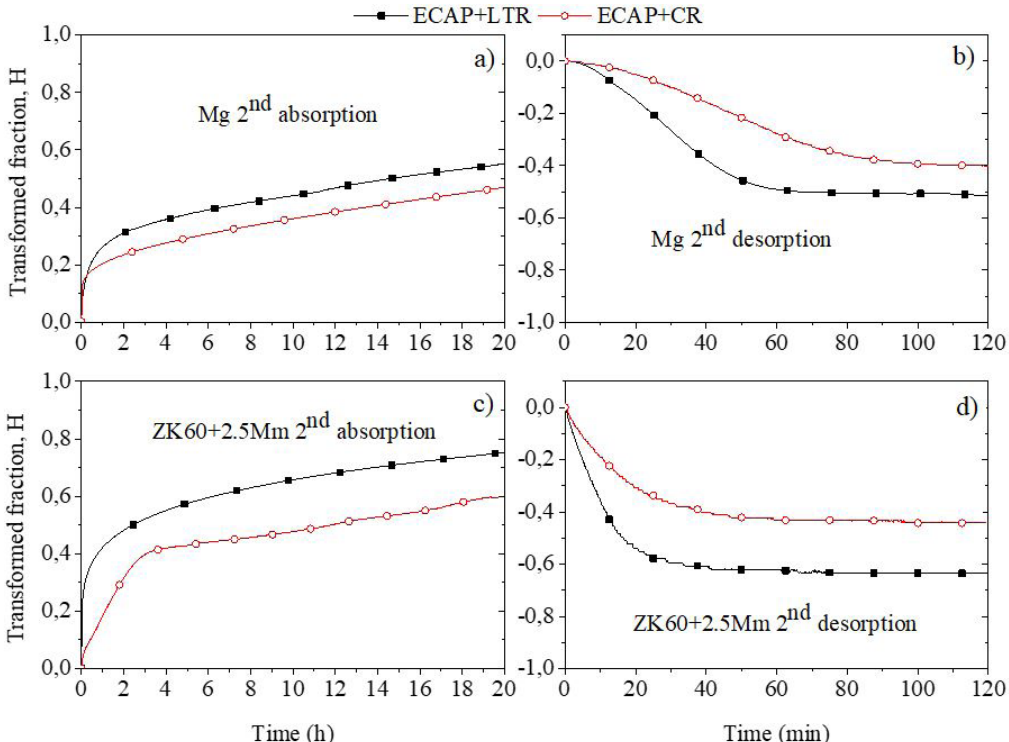
Figure 8. Kinetic curves of (a, c) second absorption and (b, d) second desorption of pure Mg and ZK60+2.5Mm alloy,